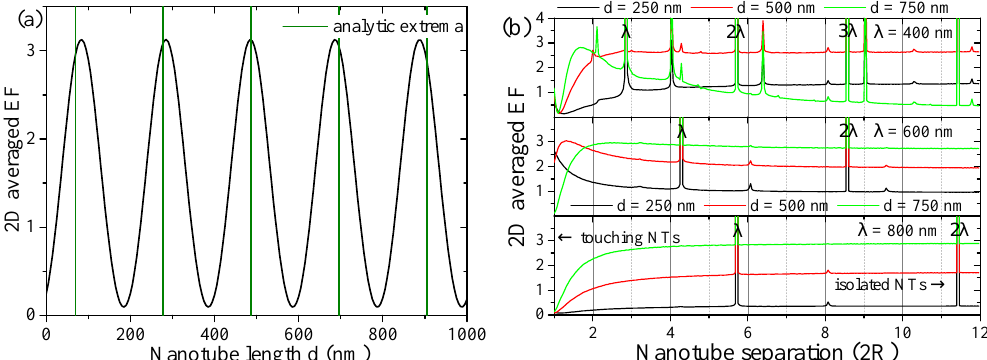
Figure 4. ( a ) Averaged field enhancement E av,2D in the unit cell at the top of the NTs z = d at λ = 600 nm as a function of nanotube length compared to analytic maxima, Equation (7); ( b ) Averaged enhancement factor | (cid:126) E av,2D | 2 / | (cid:126) E ref | 2 within the unit cell as a function of the nanotube lattice parameter a ∈ { 2 R . . . 24 R } with R = 70 nm for several nanotube lengths d and excitation wavelengths λ . Divergences are observed where the ratio a / R is an integer and, in particular, where the lattice parameter coincides with a multiple of the